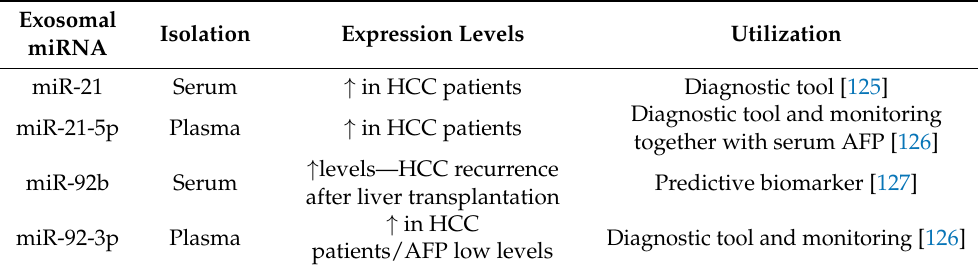
Table 4. EV-contained miRNA cargoes and their utilization as diagnostic, prognostic, and predictive biomarkers in HCC